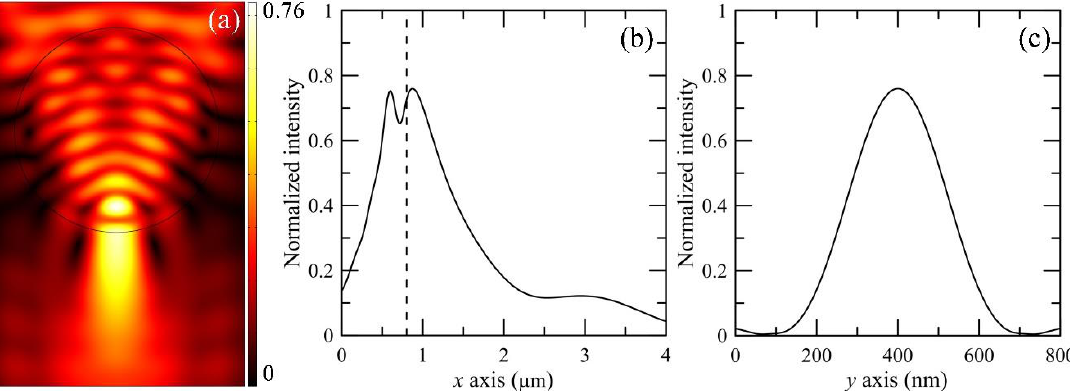
Figure 7. PNJ formed by a single microcylinder with 1600 nm diameter: ( a ) spatial intensity distribution, ( b ) normalized intensity distribution along the propagation axis, and ( c ) normalized intensity distribution along the transversal axis. The dashed line is the edge of the microcylinder.